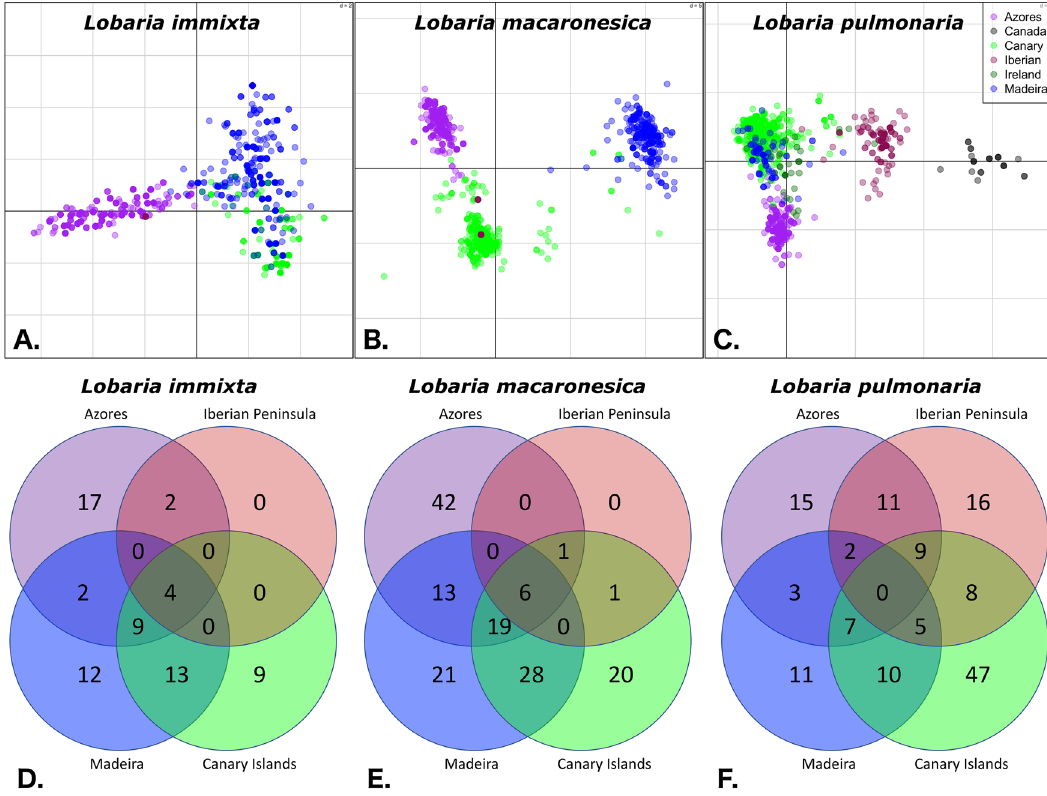
Figure 4. Microsatellite variation between geographic regions. ( A – C ) Discriminant Analysis of Principal Components (DAPC) performed in R v. 3.6.1, https:// cran.r- proje ct. org/. Sampled individuals are represented by dots, while groups are distinguished by colors. ( D – F ) Venn diagrams of the number of private and shared alleles. ( A , D ). Lobaria immixta . ( B , E ). L. macaronesica . ( C , F ). L. pulmonaria. The dimensions of grid cells were ( A ) 2, ( B ) and ( C ) 5, with the units being scores from Principal Components Analysis. The figure was compiled in GIMP v. 2.8, https:// www. gimp.